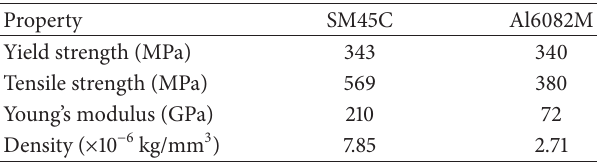
Table 1: Material properties of SM45C and